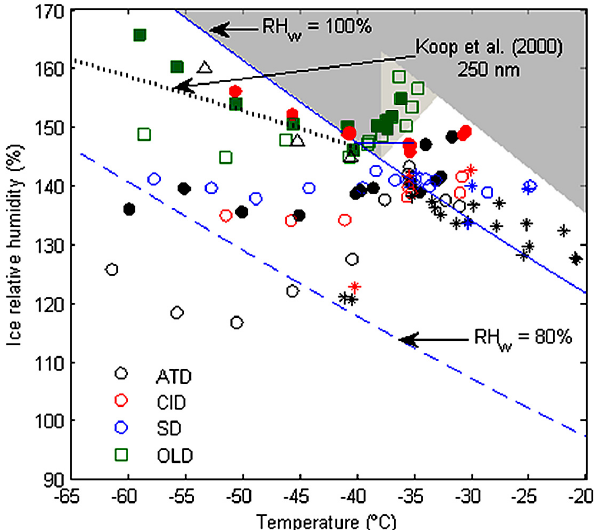
Fig. 5. Comparison of conditions for 1% activation of 200nm par- ticles as IN by ATD (black circles), CID (red circles), SD (blue circles), and Owens Lake Dust (OLD, green squares) reported from Koehler et al., (2007). Filled symbols represent those generated by atomization from aqueous suspension. Conditions for 1% of poly- disperse aerosol as IN by ATD (black stars), CID (red stars) and SD (blue stars). Conditions for 1% activation of 250nm coated ATD (black triangles). The dark gray shading indicates the region where droplets are known to be counted by the OPC in the CFDC systems. The light gray shading indicates the transition where the state of the particle counted by the OPC is ambiguous. Water saturation, RH w = 80% and the conditions for which 250nm (NH 4 ) 2 SO 4 par- ticles nucleate ice according to Koop et al. (2000) are indicated in the figure for